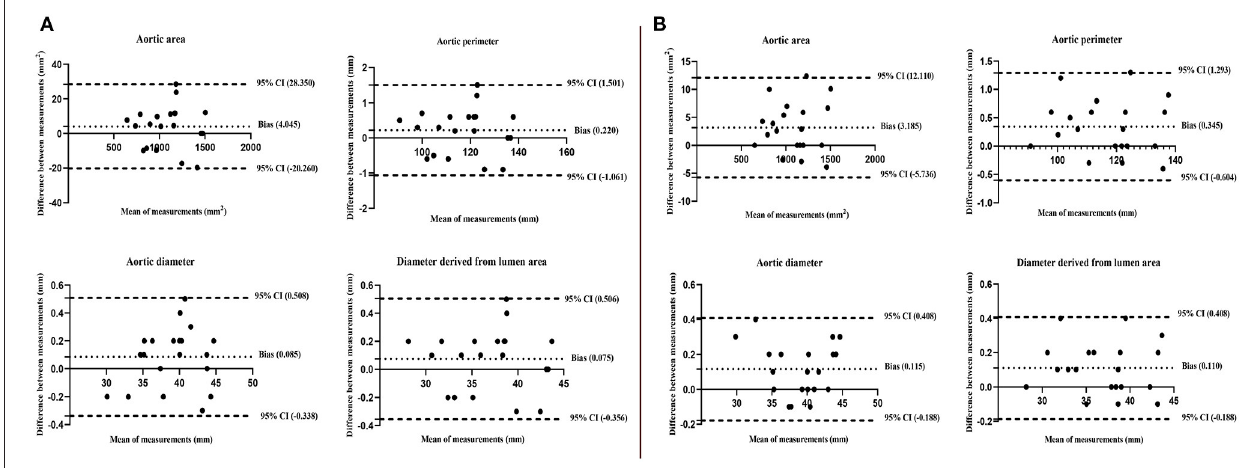
FIGURE 5 | Bland-Altman plots show high consistency of inter-observer (A) and intra-observer (B) for the aortic area, perimeter, diameter, and diameter derived from the lumen area at level A. The upper and lower limits of each measurement difference during the cardiac cycle were included in the 95%